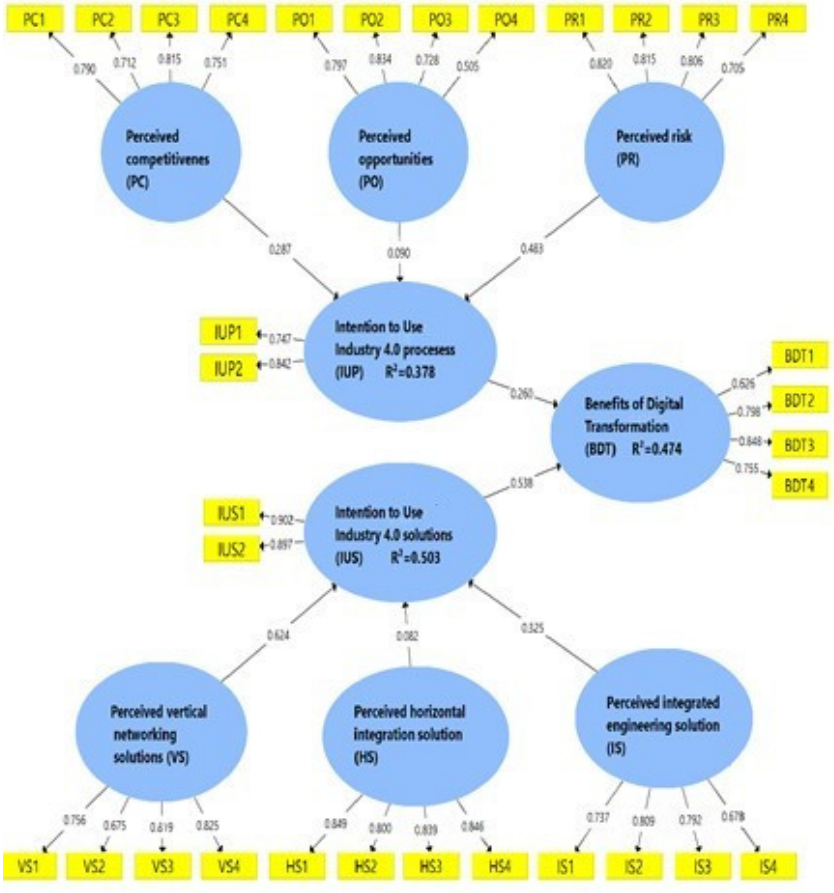
Figure 2. Description of the results obtained after applying Partial Least Square–Structural Equa- tion Modeling